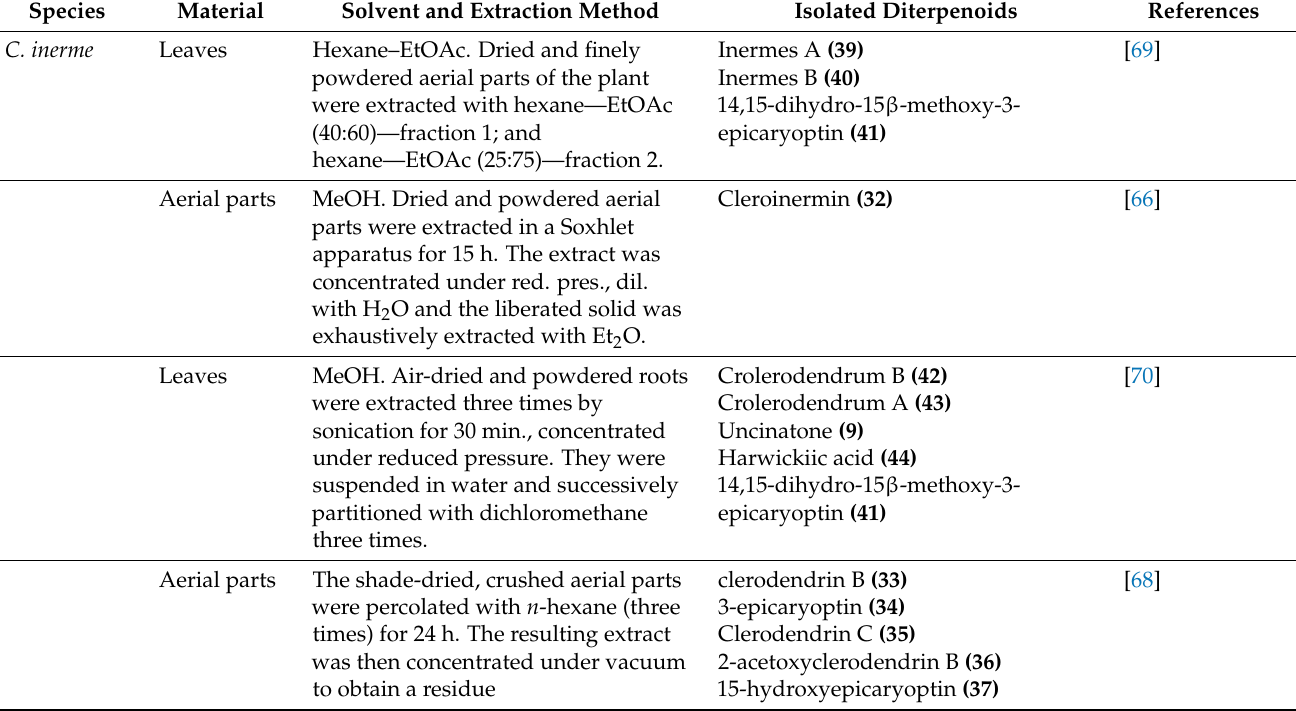
Table 5. The diterpenoid extraction methods and C. inerme plant materials for diterpenoid isolation. Species Solvent and Extraction Method Isolated